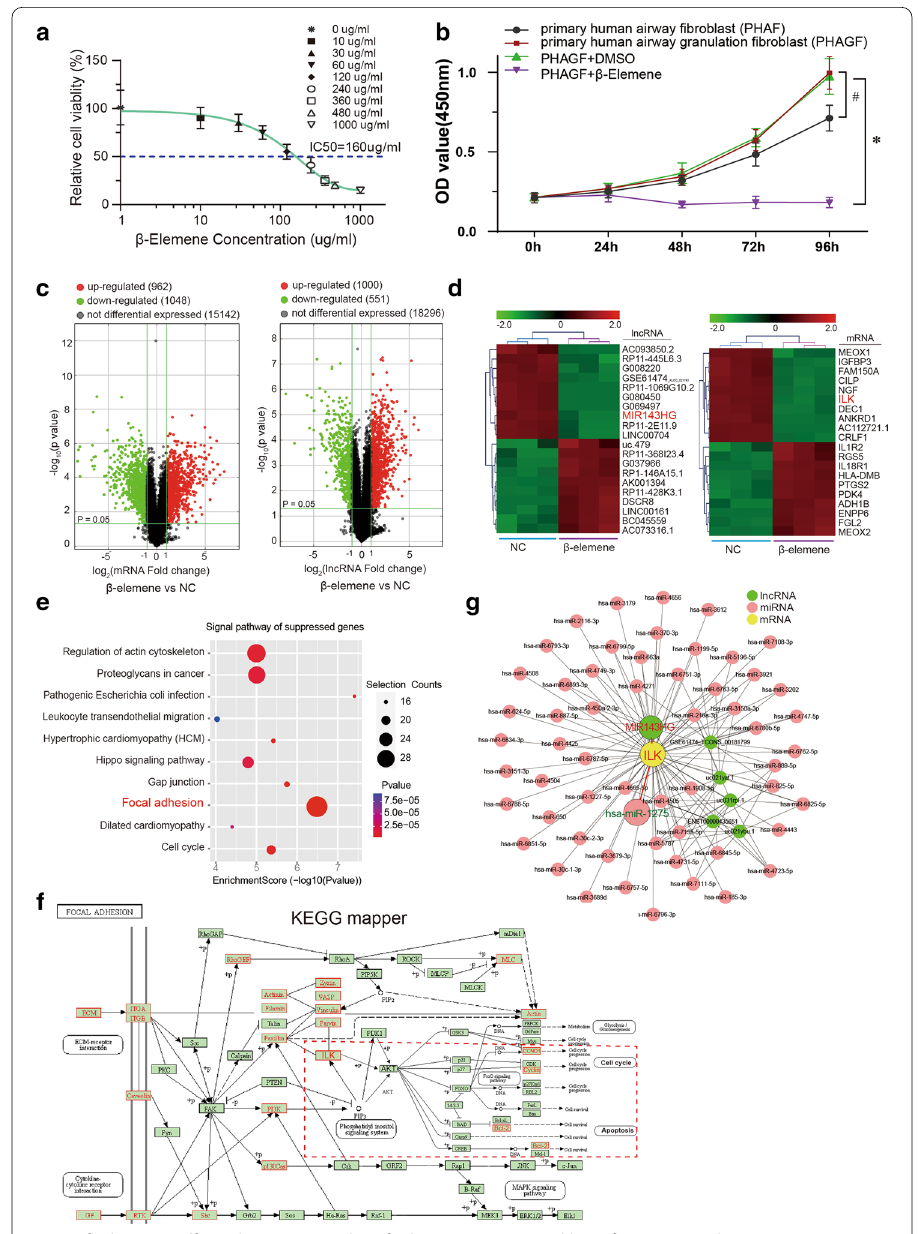
Fig. 1 β-Elemene-affected ceRNA axis identified via microarray and bioinformatics analysis a Determination of the IC50 of β-elemene in primary human airway granulation fibroblasts (PHAGF) used in subsequent experiments including microarray analysis. b CCK ‐ 8 assay-detection of the proliferation of primary human airway fibroblasts (PHAF), PHAGF and β-elemene-treated PHAGF. * P < 0.05, # p < 0.05. c A volcano plot was generated to show the differential expression distribution via microarray analysis. d Heatmap of the top 10 differentially expressed lncRNAs and mRNAs in PHAGF after β-elemene treatment. Green indicates down-regulation, red indicates up-regulation. e A dotplot depicts the top 10 suppressed pathways with the highest enrichment scores identified by KEGG pathway enrichment analysis in β-elemene-treated PHAGF. f Differentially expressed mRNAs were mapped to the focal adhesion pathway network via KEGG mapper tools. Red solid-line box represents down-regulated gene; large red dashed box indicates the ILK/Akt sub-pathway. g Visualization of ILK-centered ceRNA regulatory network constructed from bioinformatic